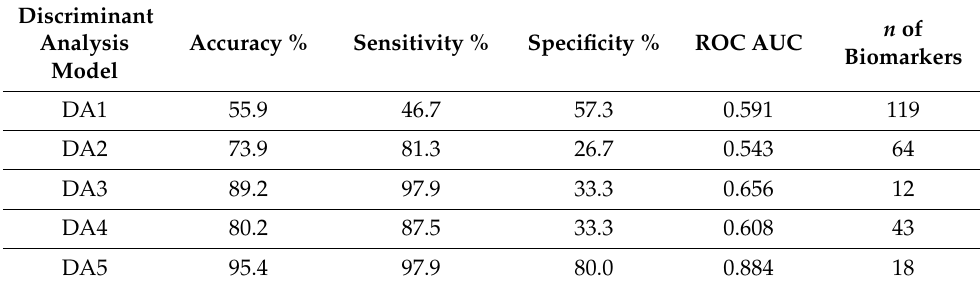
Table 3. Discriminant analysis for classification of AR– samples in healthy and tumor samples.